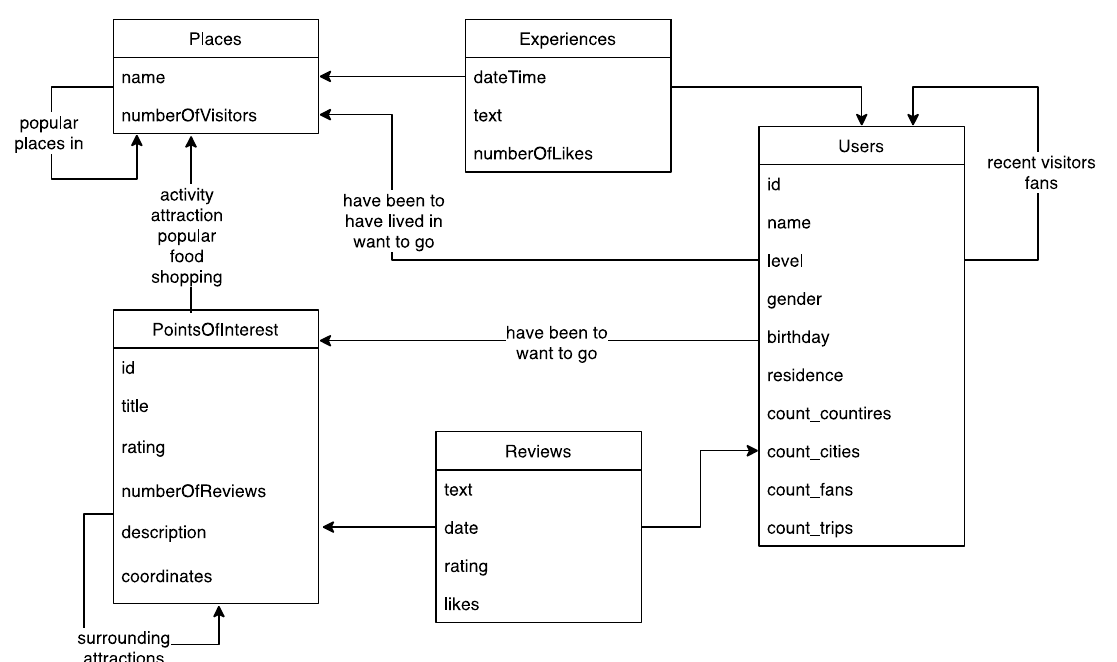
Figure 1. Reverse engineered structural data model for information extraction from the Qyer weblog. Rectangles represent entity sets, including their attributes, and arrows symbolize relationship sets instantiated by references found on the website.